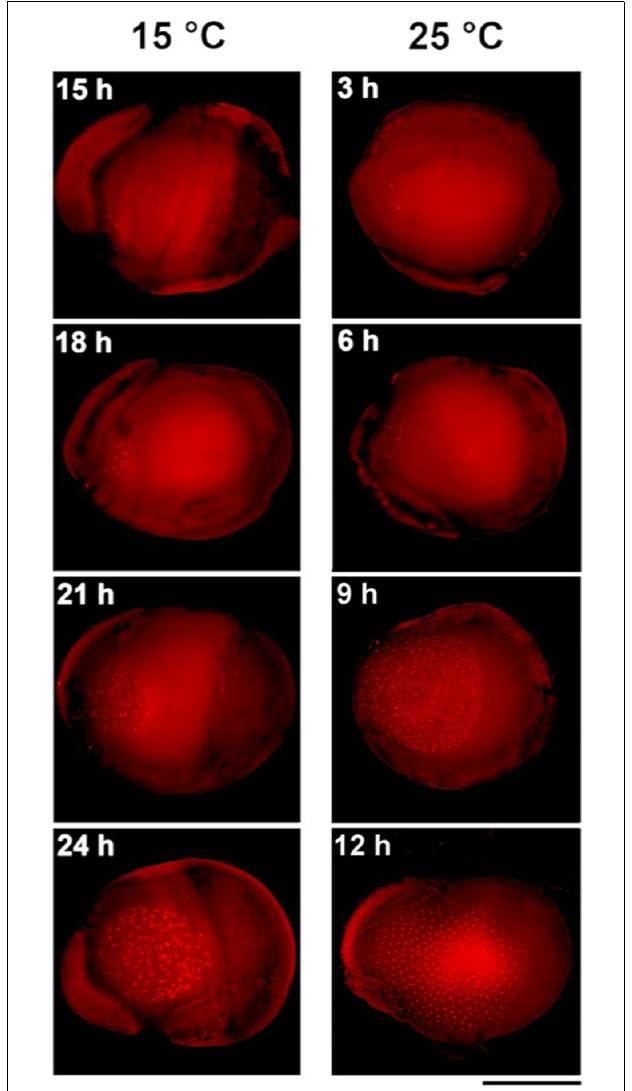
FIGURE 3 | Comparison of early embryogenesis in standard breeding strain K23 incubated at 15 ◦ C and 25 ◦ C, respectively. The inserted numbers indicate the time after egg activation. Scale bar: 500 µ